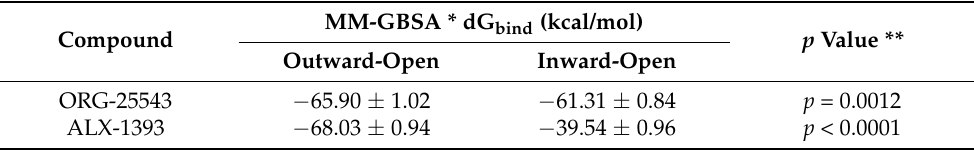
Figure 10. RMSD changes observed for ORG-25543 and ALX-1393 in a complex with GlyT-2 in the outward-open state in the course of MD simulations ( A ). Stability of the key interactions between the ligand and the transporter for ORG-25543 ( B ) and ALX-1393 ( C ). The presence of interactions in a particular MD frame is marked in color. Table 2. MM-GBSA binding free energy values for ORG-25543 and ALX-1393 in complex with GlyT-2 in the outward-open and inward-open states. MM-GBSA energy value was calculated for the frames derived from the last 2 ns of 50-ns